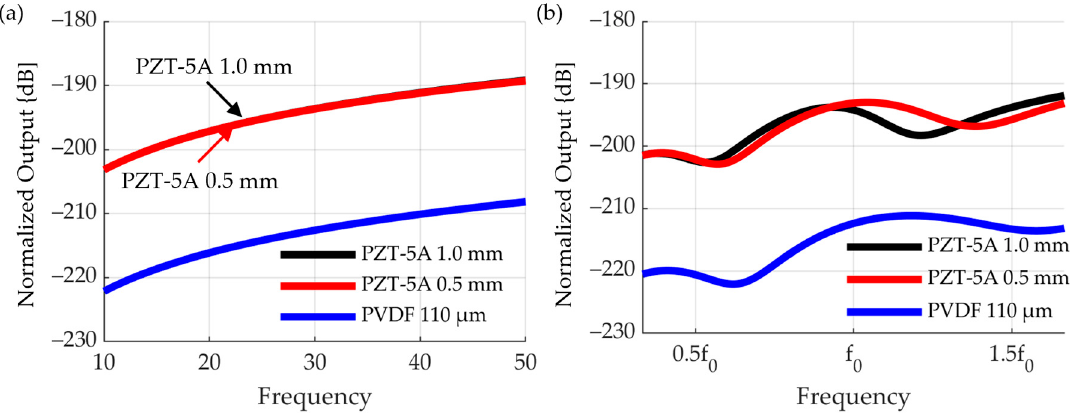
Figure 7. Receiving sensitivity of each material in ( a ) RX 1 ( b ) RX 2.